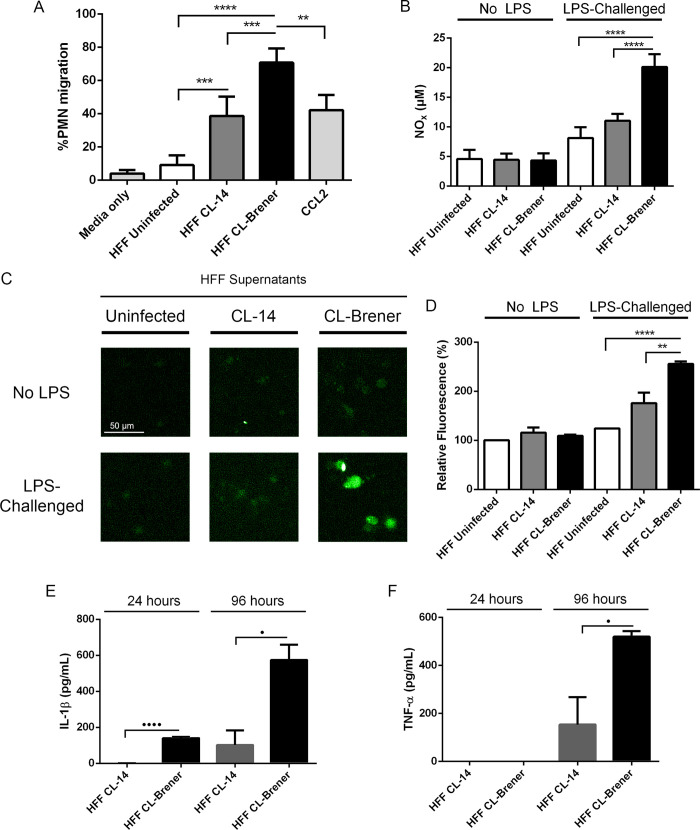
Human neutrophils are activated by supernatants from T. cruzi-infected HFF cells.(A) Migration assays of neutrophils incubated for 16 hours with media only, supernatants from uninfected HFF cells, supernatants of HFF cells infected for 4 days with T. cruzi CL-14 or CL Brener, and with purified CCL2 (500 ng/mL). (B-D) NO (B) and ROS assays (C-D) of neutrophils incubated for 16 hours with media only, supernatants from uninfected HFF cells, supernatants of HFF cells infected for 4 days with T. cruzi CL-14 or CL Brener and then challenged with 200 ng/mL LPS for one hour. IL-1β (E) and TNF-α (F) production in PMNs incubated for 24 and 96 hours with supernatants of HFF cells infected for 4 days with T. cruzi CL-14 or CL Brener. No TNF-α nor IL-1β detected in PMNs treated with media only or supernatants from uninfected HFF. * p < 0.05, ** p < 0.01, *** p < 0.001, and **** p < 0.0001 (one-way ANOVA with Tukey’s post-test comparing the indicated treatments). • p < 0.05 and •••• p < 0.0001 (unpaired t-test comparing the indicated treatments). (C) Image is representative of three independent experiments. (A) Data from four independent experiments (mean and s.e.m.). (B, D-F) Data from three independent experiments (mean and s.e.m).